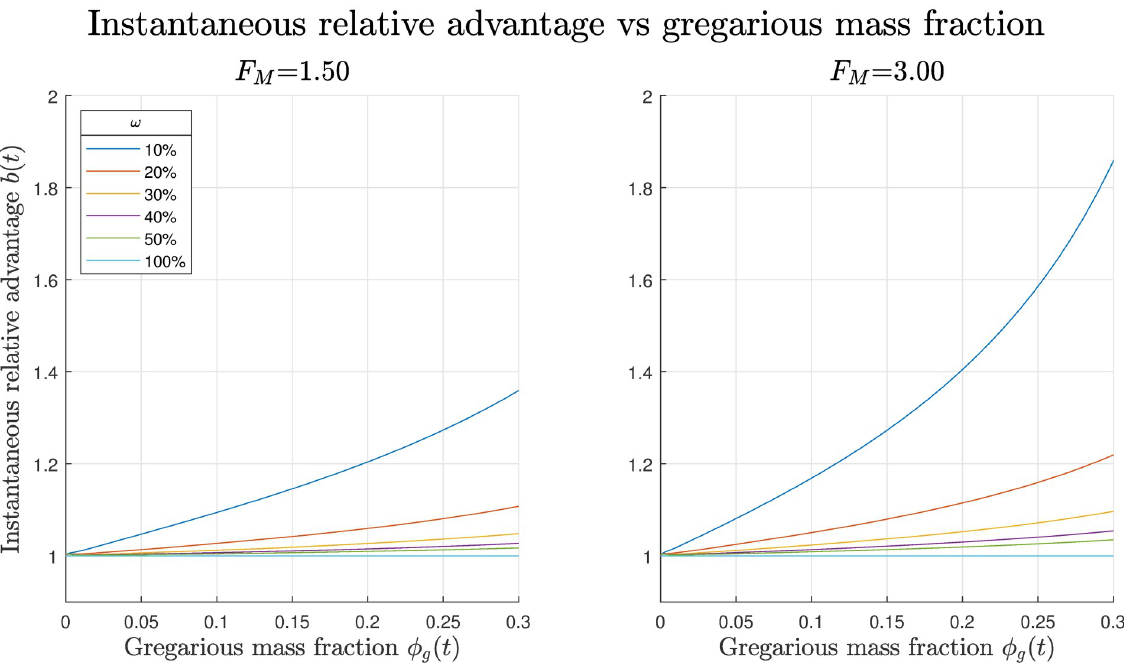
Fig 7. Instantaneous relative advantage of gregarious locusts vs gregarious mass fraction at various food footprints and food masses. In these simulations ρ amb = 0.95 and κ = 0.09, with the symmetric parameter set. The homogeneous food source is labelled ω = 100%. It can be seen that as the gregarious mass fraction increases so too does the foraging advantage of being gregarious, this effect is increased by the mass of food present but is diminished by the size of the food